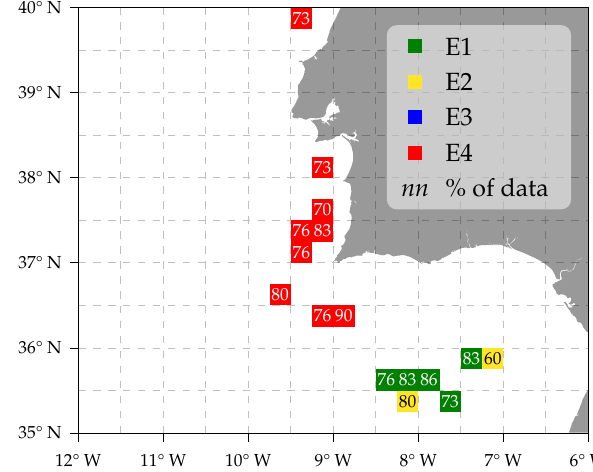
Figure 7. Labels given to each square of the grid, depending on their